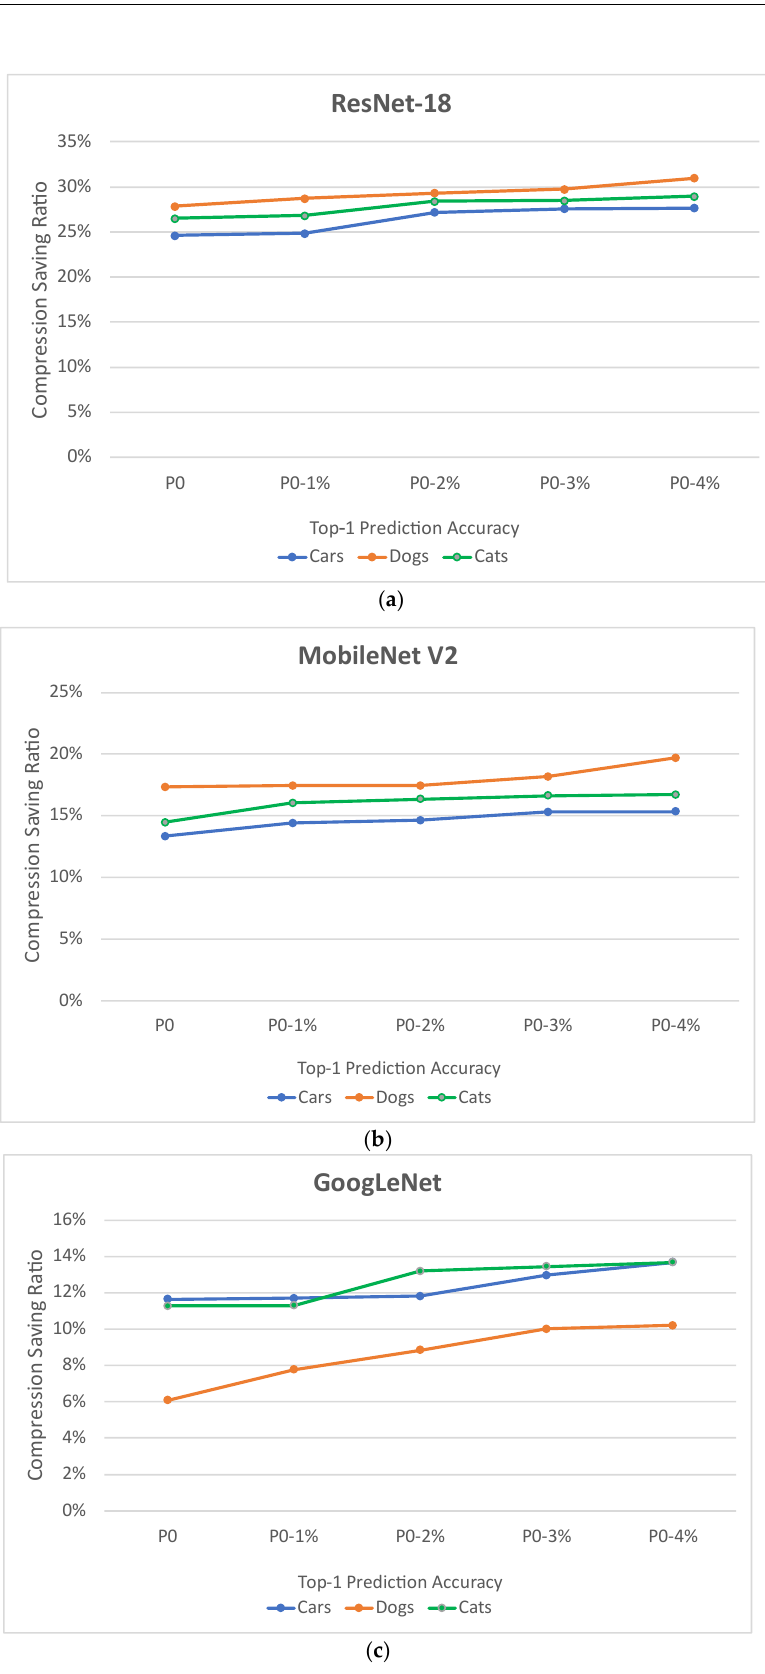
Figure 5. Compression-saving ratios for ( a ) ResNet-18, ( b ) MobileNet V2, and ( c ) GoogLeNet versus prediction accuracy for specialized tasks.